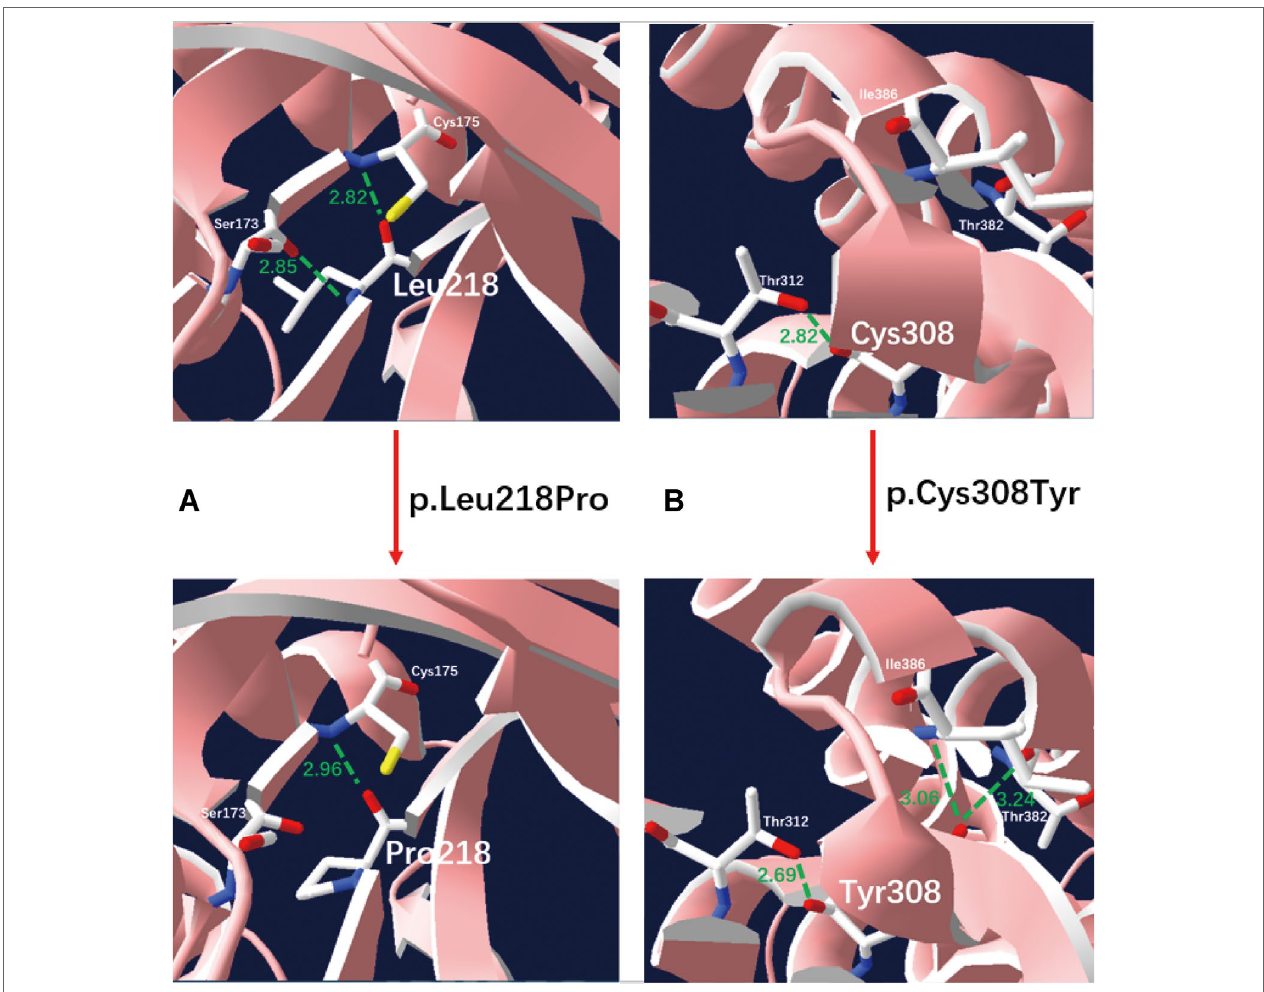
FIGURE 1 | Three-dimensional structure analysis modeling of wild-type and SBCAD mutant products. Green dashed lines represent hydrogen bonds and the green number shows the hydrogen bond distances. (A) The p.Leu218Pro variant may affect the ACADSB quaternary structure by losing intramolecular hydrogen bonding with 173-Ser. Thus, the protein product would be unstable and most likely be rapidly degraded. (B) The p.Cys308Tyr variant may alter the side chain conformations of the residues in the FAD cofactor binding cavity by inducing intramolecular hydrogen bonding with 382-Thr and 386-Ile, which may block the binding of